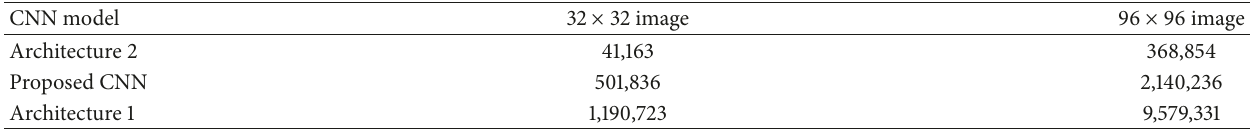
Table 2: Overview of learnable parameters for the CNN